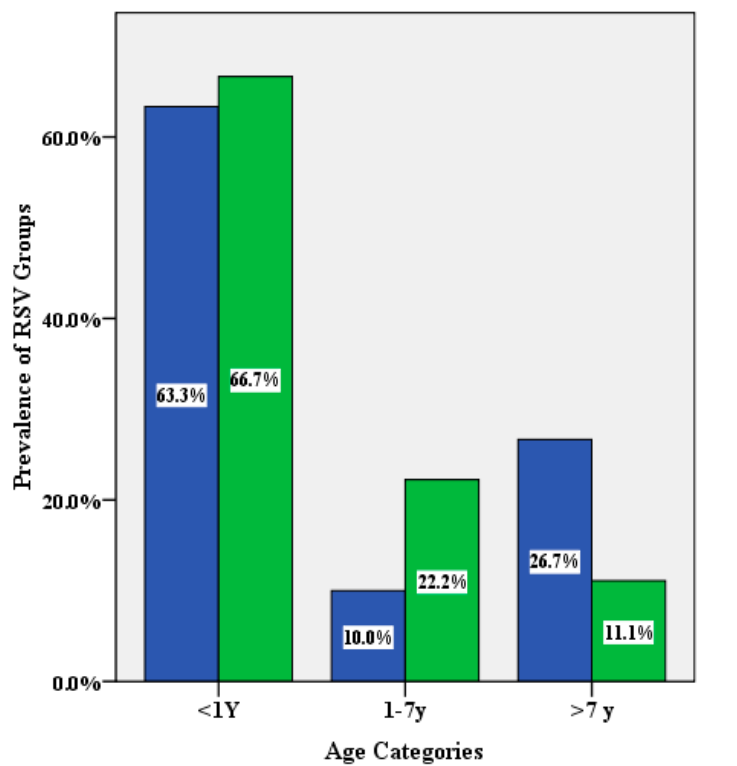
Figure 1. The age distribution of human respiratory syncytial virus (HRSV) groups in the recruited cases.